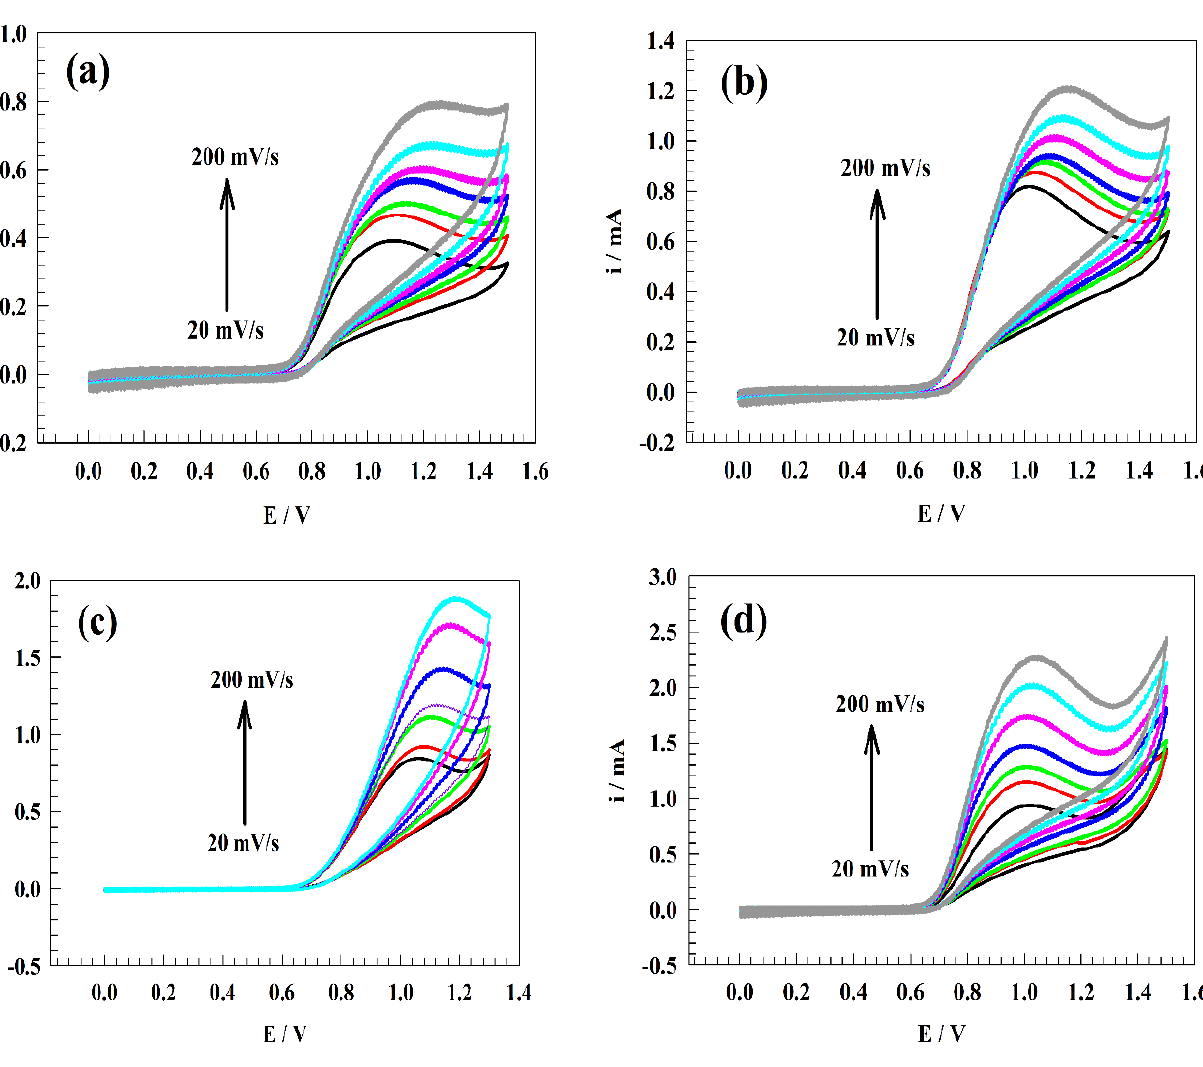
Figure 6. ( a ) CVs of the GC/PANI/NiOnF in 0.5 mM nitrite solution at different pH values. ( b ) The dependence of oxidation current on the pH of the solution.